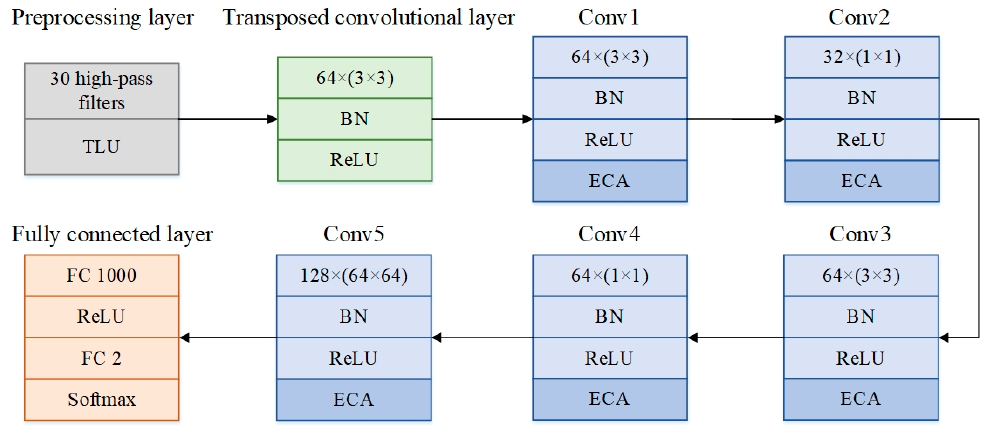
Figure 1. The detailed structure of the proposed TCSI-ECA-Transfer model. Each grid represents the details of each layer. “ a × ( b × b )” means that the size of the convolution kernel is b × b and the number of input channels is a .